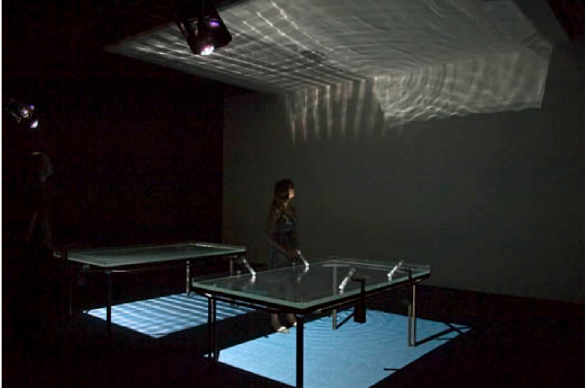
Figure 7 | Rafael Lozano-Hemmer, Pulse Tank , 2008. Photo by Scott